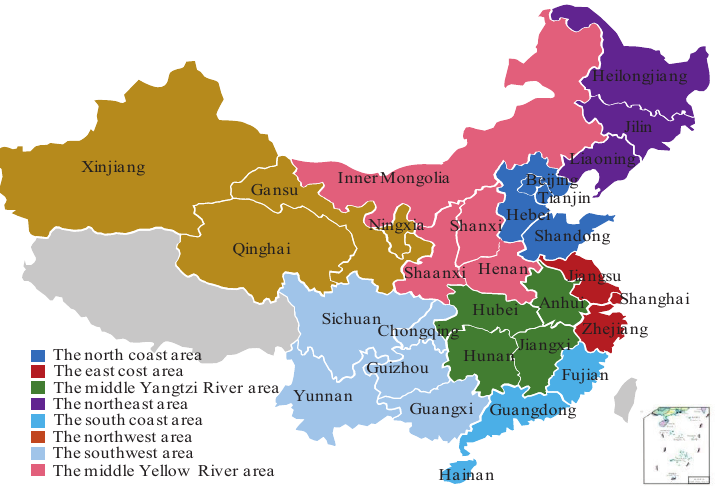
Figure 8. The division of eight economic-geographic regions in